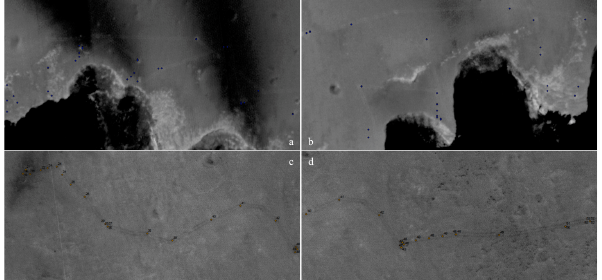
Figure 7. Co-registered rover positions on MER-B (a,b) and MSL (c,d) HiRISE ORI showing alignment between the corrected traverse and rover tracks In terms of validation, HiRISE images are captured at different times covering the same area for the three rover missions. These have been collected, projected, and co-registered with CTX and HRSC ORIs at MSSL. Some of them contain rover tracks in different areas. The corrected traverses are validated in the comparison of rover tracks appearing in different HiRISE images. For MER-A, there are not enough places containing good structural features that appear in both HiRISE and NavCam ORI mosaic for us to perform a co-registration. In such situations, we use an alternative workflow to derive the rover track segments in different HiRISE images, using the line- fitting method to match the rover tracks with traverse segments after IBA correction. The traverse is validated using different rover track segments appearing in different HiRISE